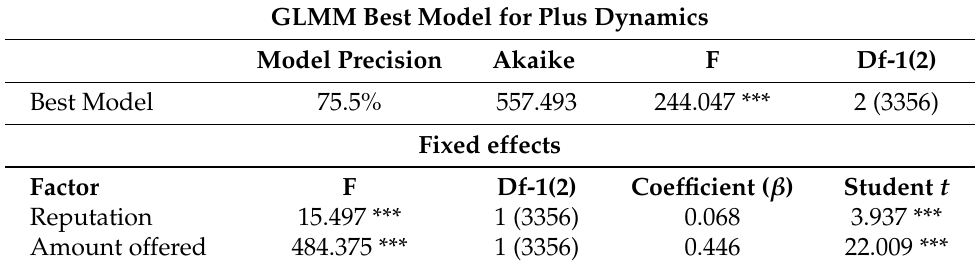
Table 5. Generalized Linear Mixed Models 3. Plus dynamics.